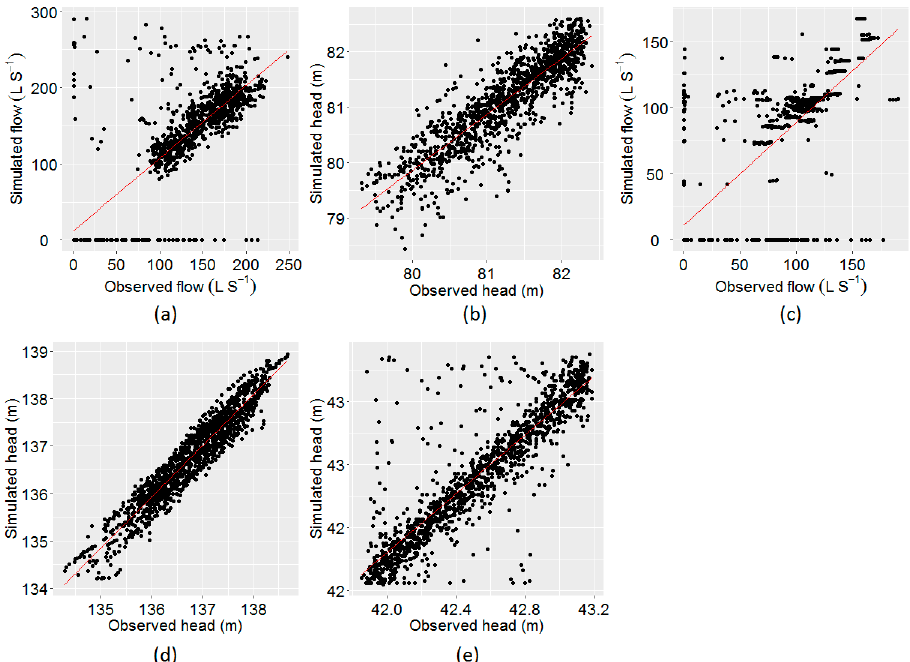
Figure 3. Plot of observed vs. model ‒ simulated values using EPANET. ( a ) Flow at PS1, ( b ) head at Coomandook tank, ( c ) flow at PS2, ( d ) head at Binnies tank, and ( e ) head at Meningie tank.